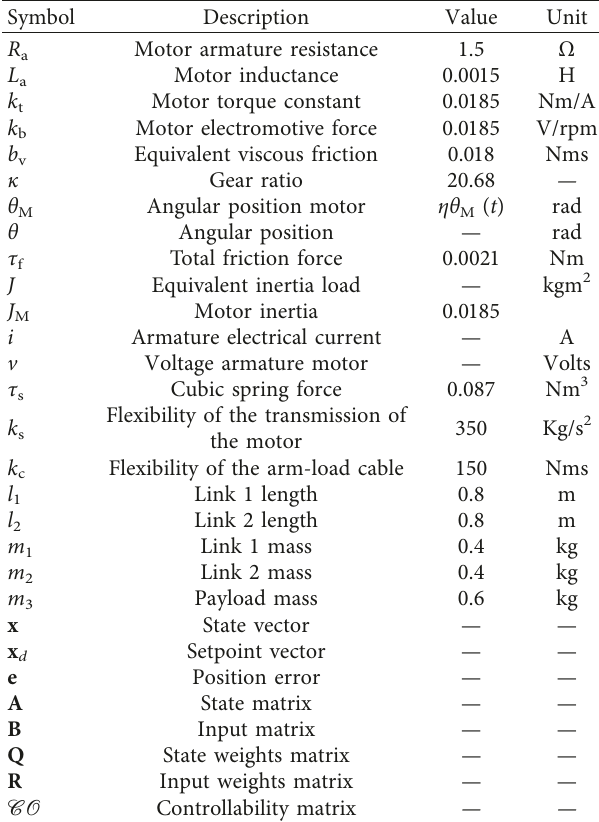
Figure 5: Kinetic energy exchange between load and manipulator with nonideal load. Table 1: Parameters of the robot manipulator arm